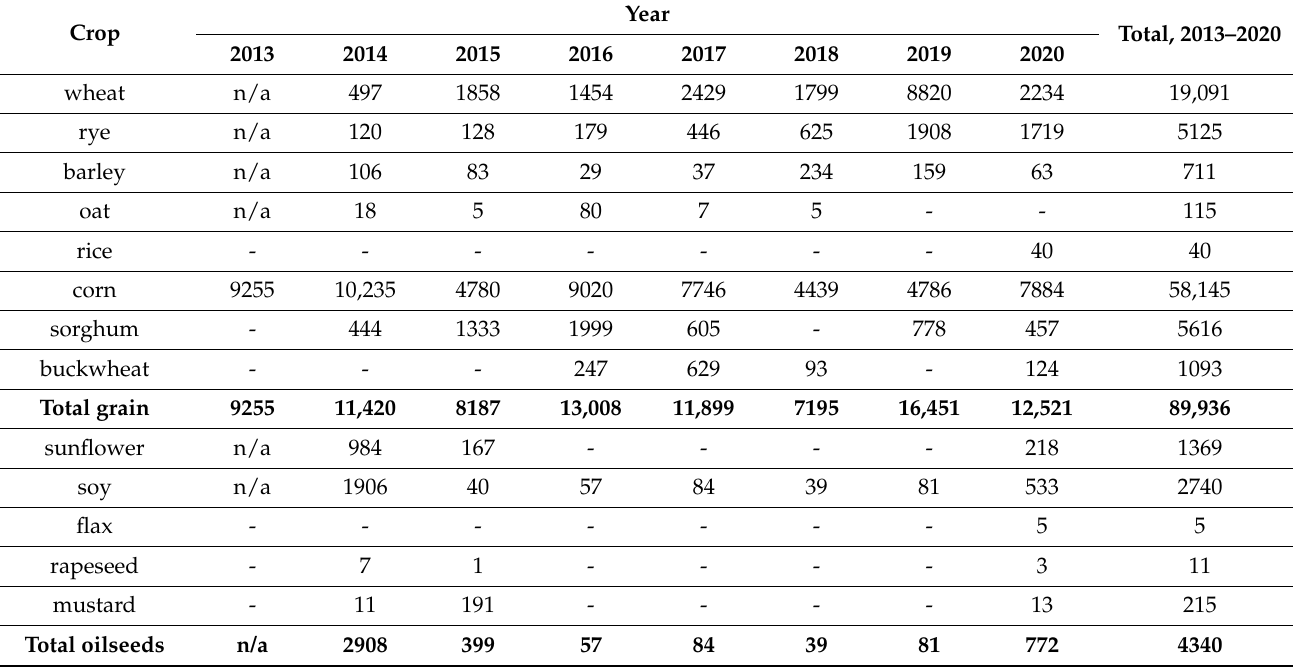
Table 2. Export of grain and oilseeds over 2013–2020, in